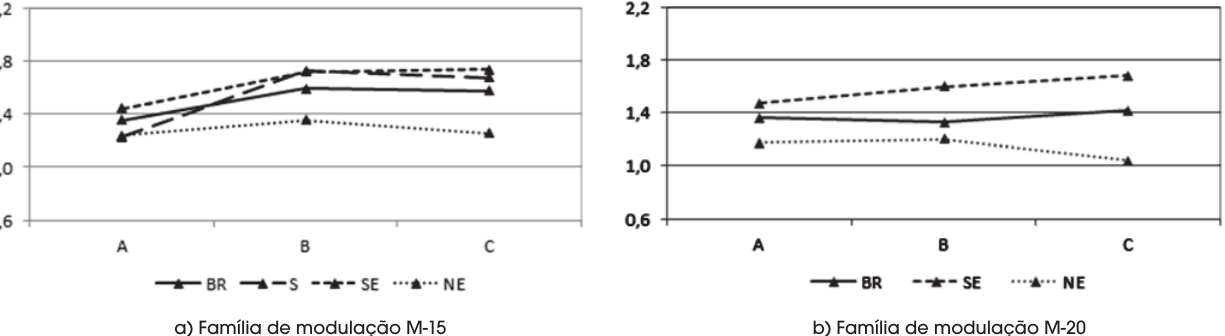
Figura 2 Razão entre a resistência média e a resistência característica especificada (f famílias de